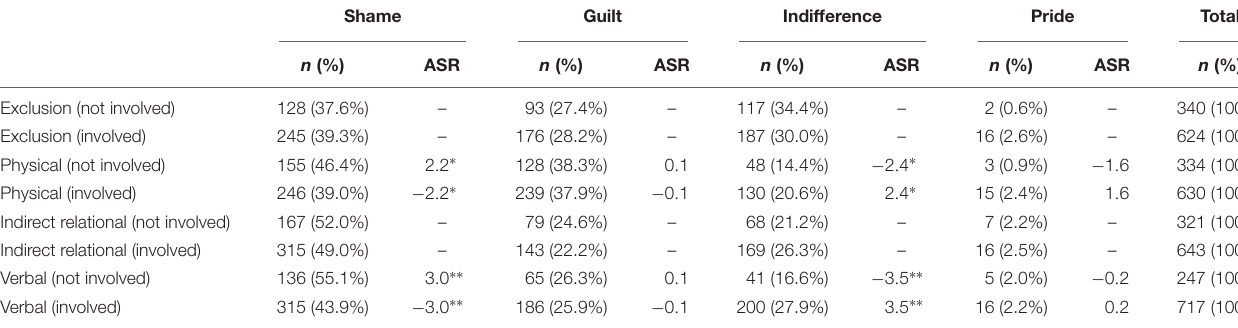
TABLE 6 | Percentages of moral self-attribution of victims and those not involved. Shame Guilt Indifference Pride